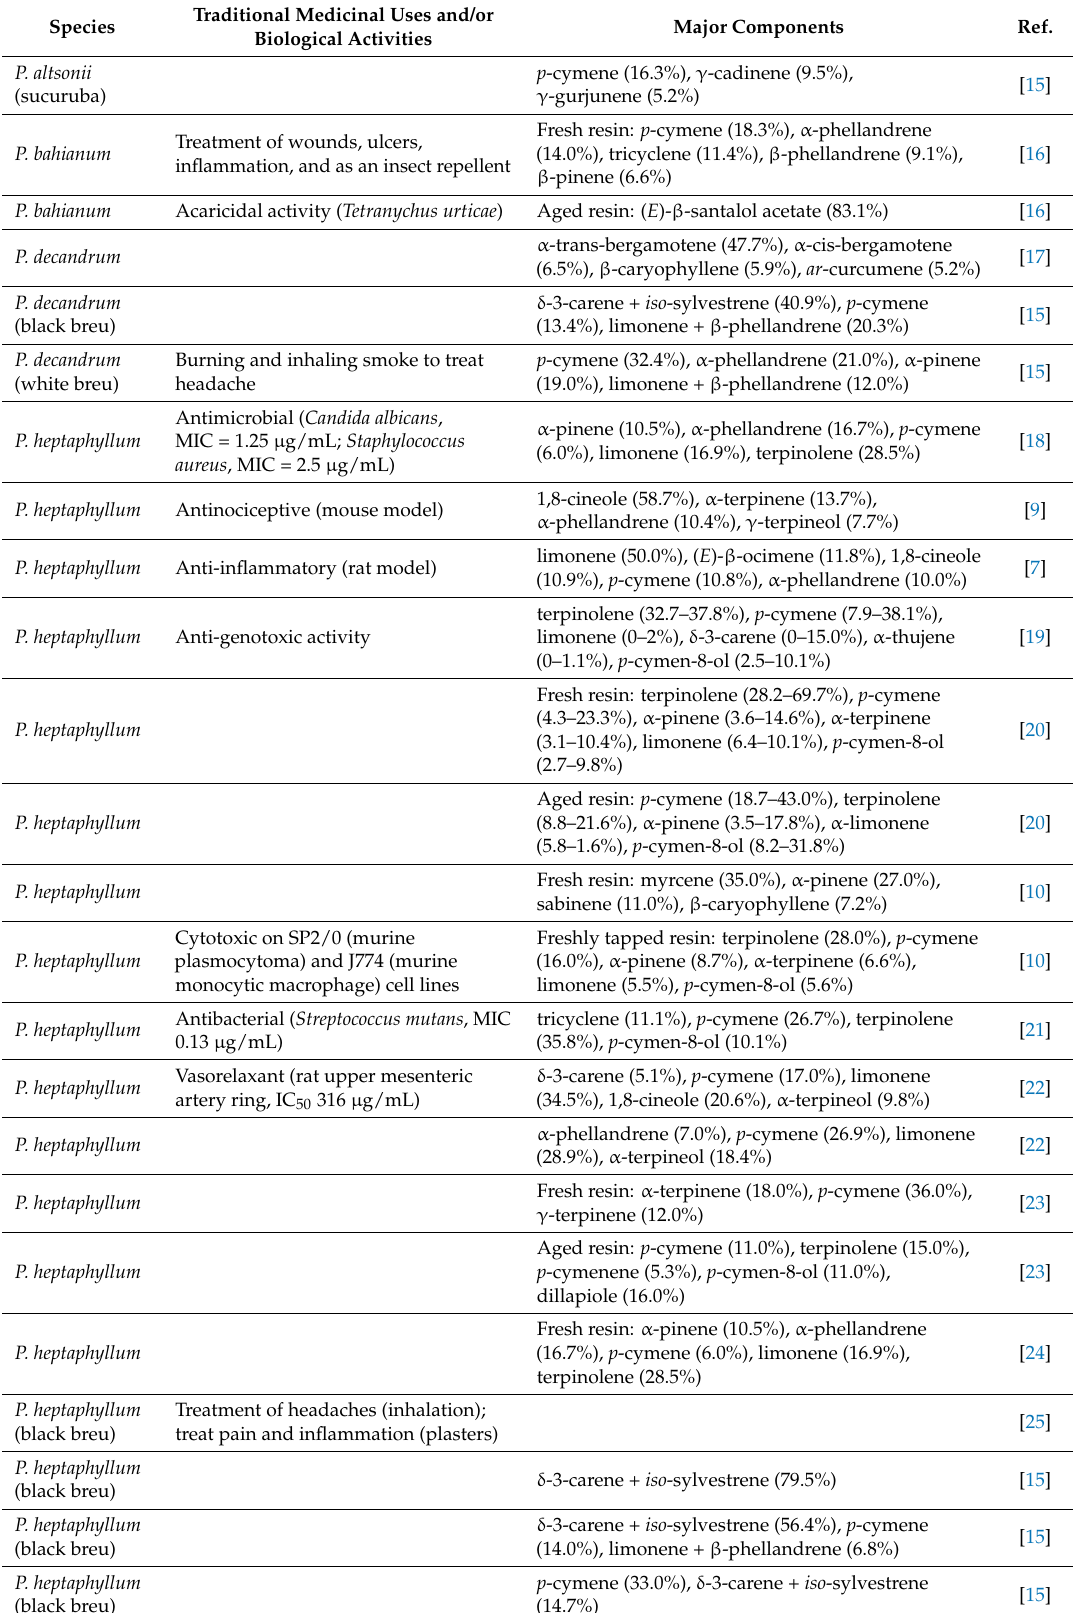
Table 1. A brief review of Protium oleoresin traditional medicinal uses, biological properties, and essential oil compositions.